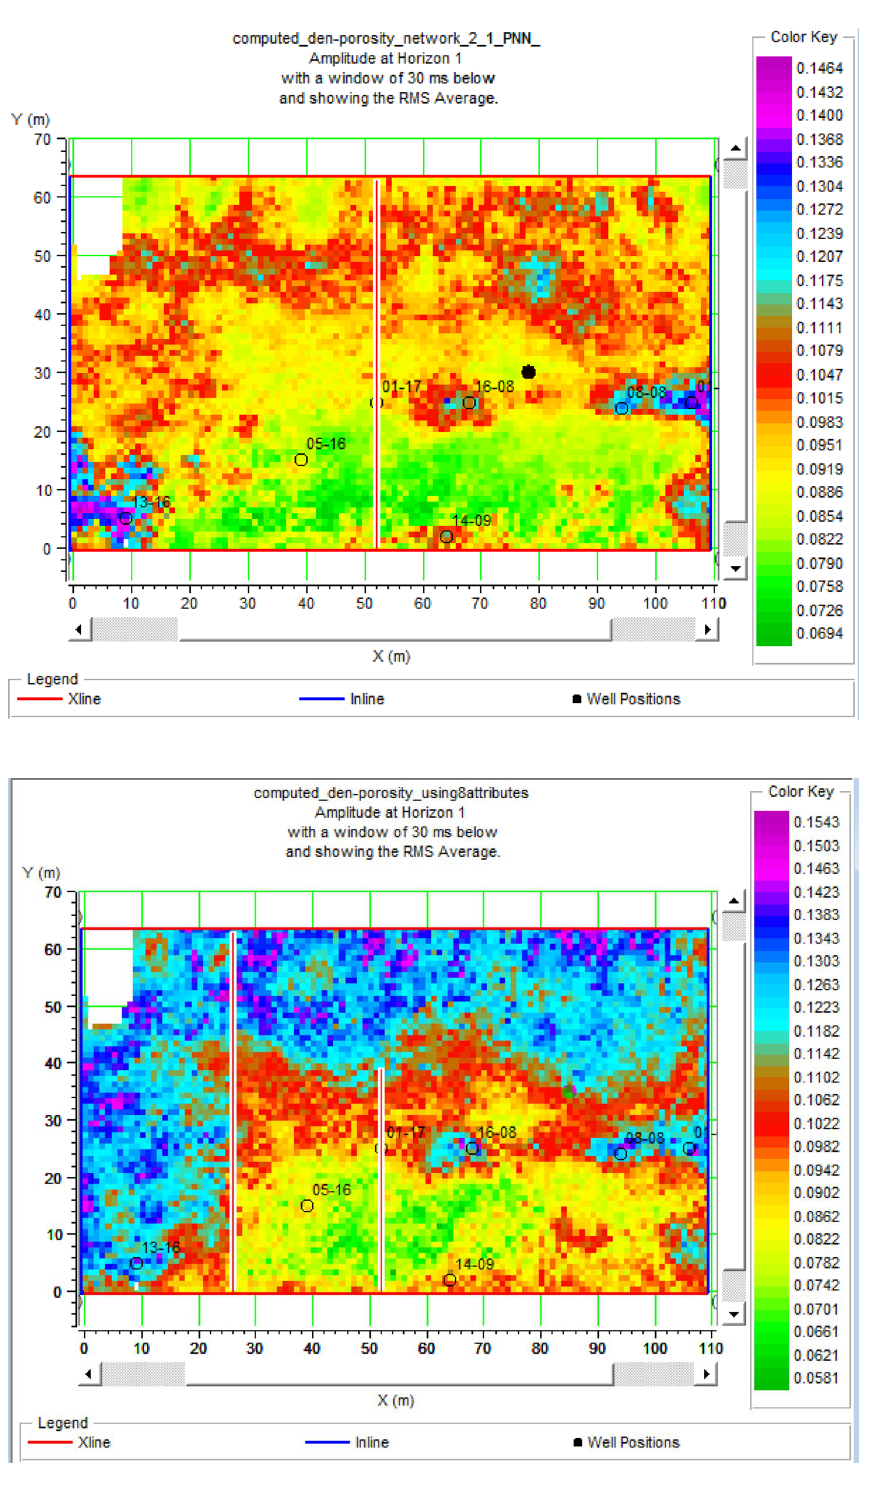
Fig. 38 2D porosity from PNN_dataset2